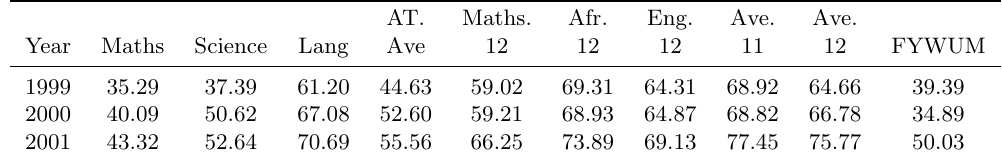
Table 3: Means of the variables of the Test Battery 1 data set for the 1999, 2000 and 2001 intake